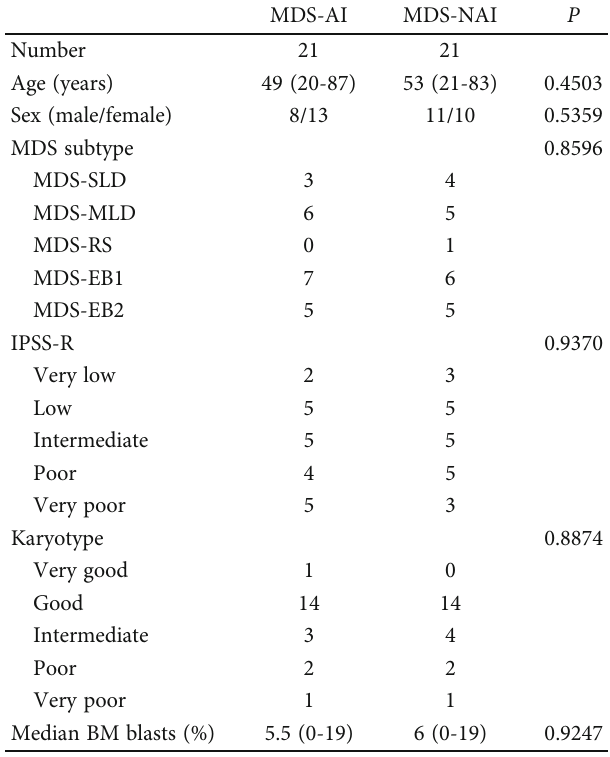
Table 1: The characteristics of MDS patients with autoimmune diseases.